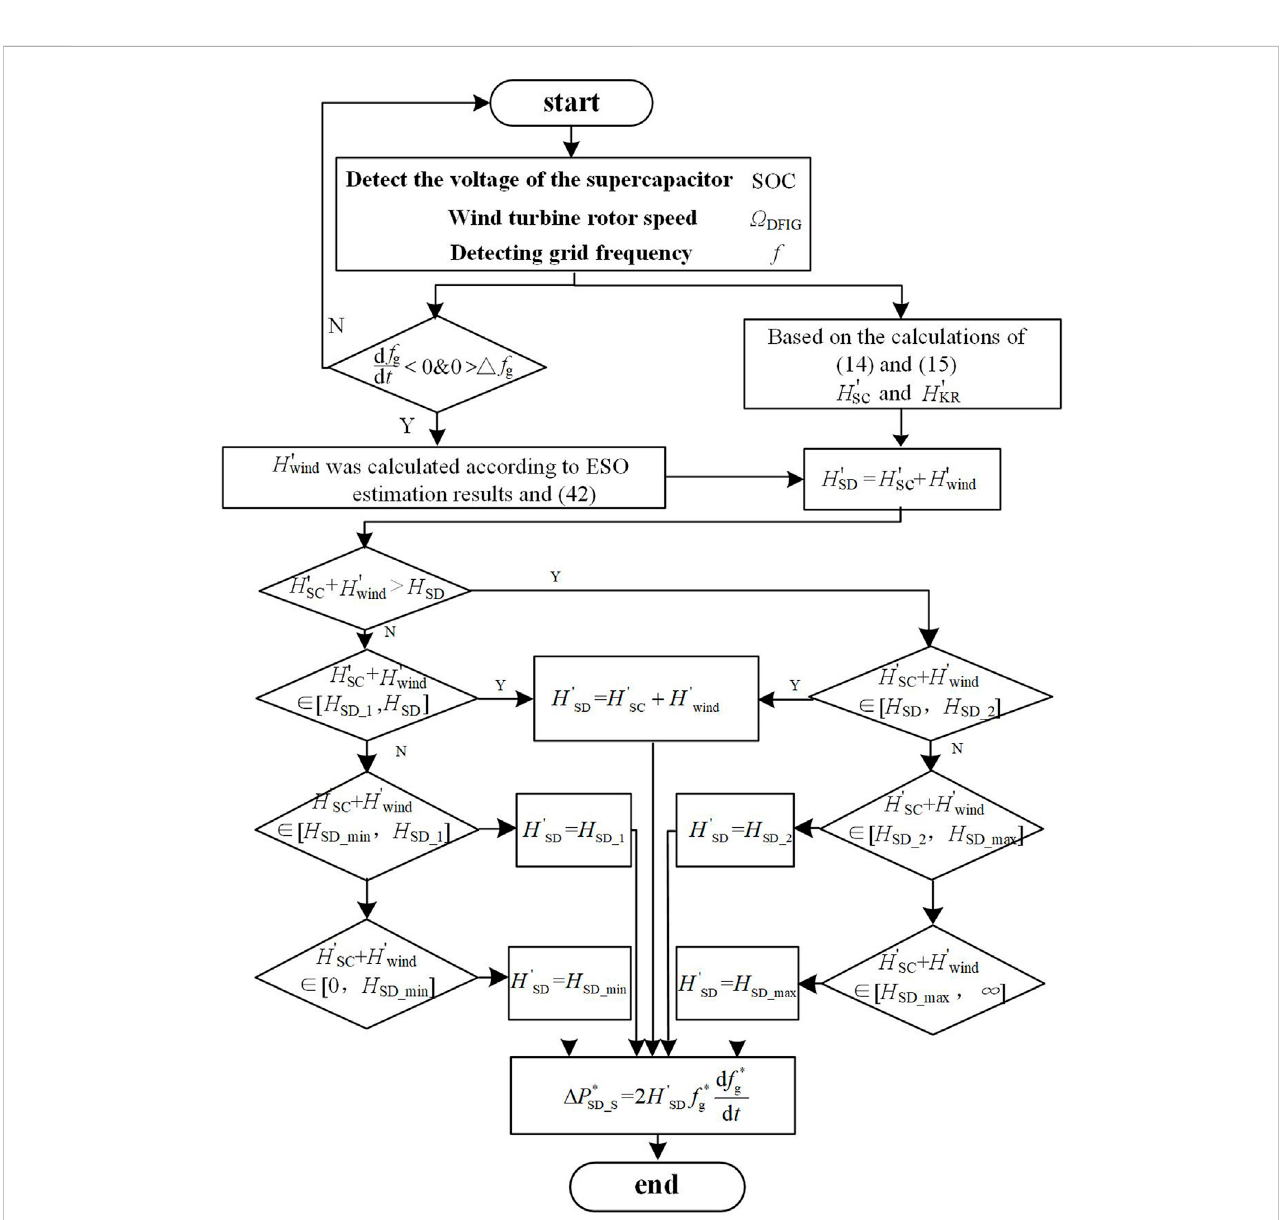
FIGURE 7 Power control fl ow chart of inertia response based on actual system running state.